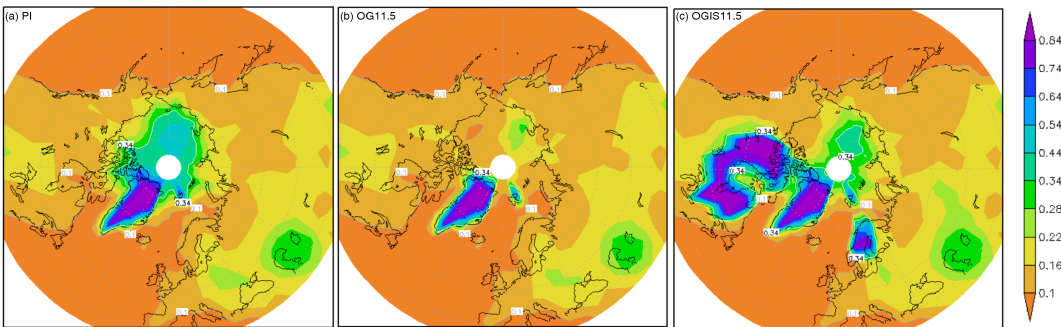
Figure 11. Summer surface albedo in the extratropical Northern Hemisphere. Panels (a) , (b) and (c) represent the control run (PI) and the simulations without ice sheets (OG11.5) and with ice sheets (OGIS11.5),